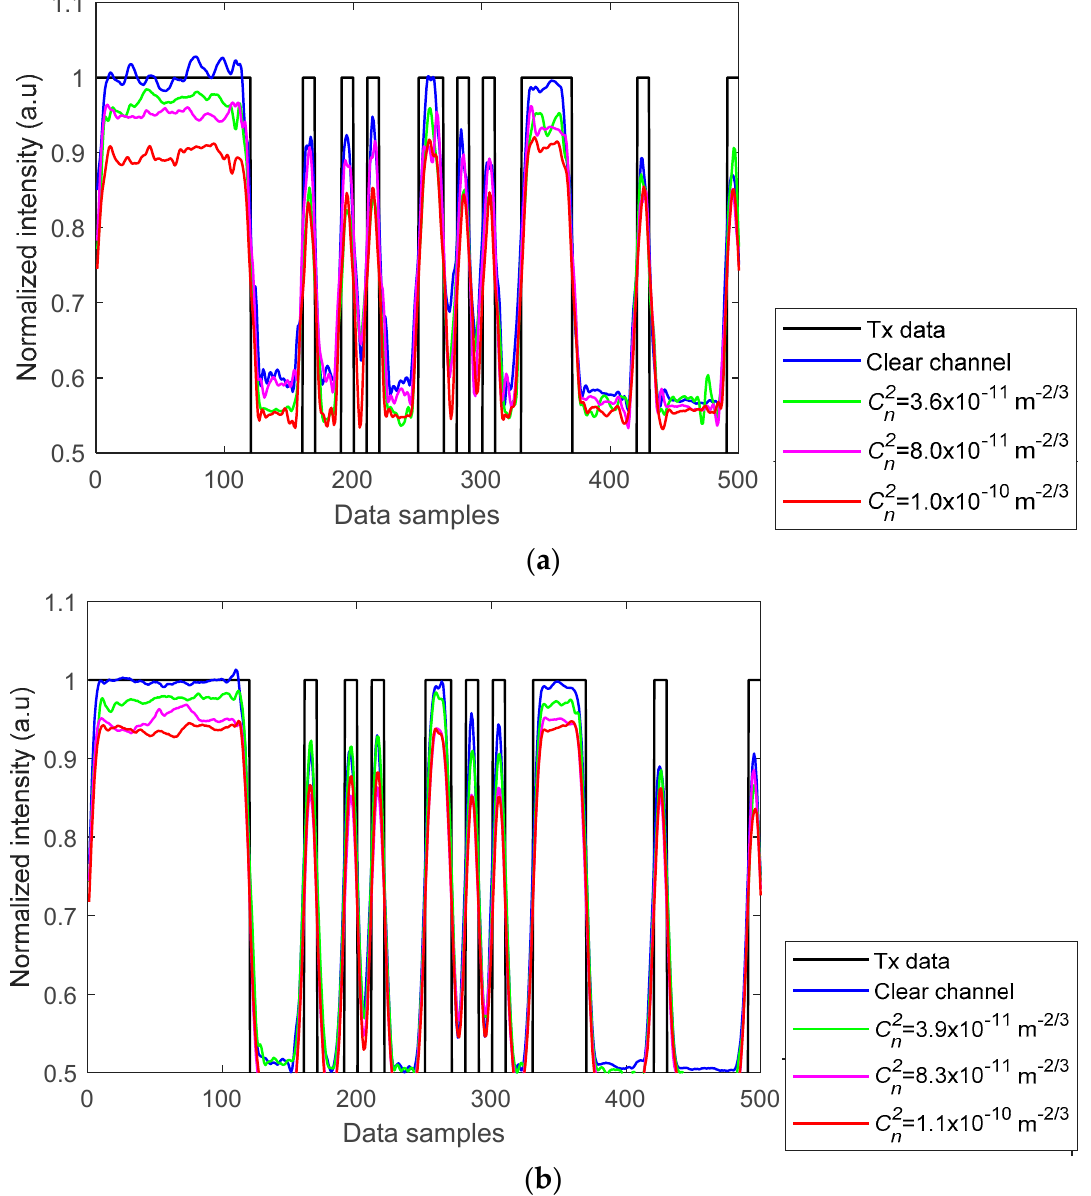
Figure 6. Waveforms of Rx data at varying AT strengths for the gain factors of: ( a ) 1.07 × and ( b ) 3.96 ×